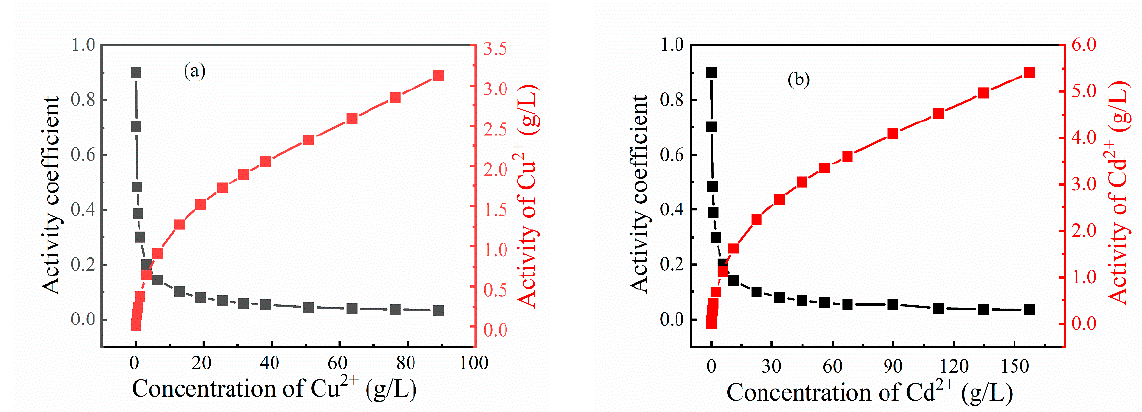
Figure 4. Activity coefficients of Cu and Cd sulfate solutions calculated by the Pitzer model and the relationship between activity and concentration: ( a ) activity coefficients of Cu; ( b ) activity coefficients of Cd.